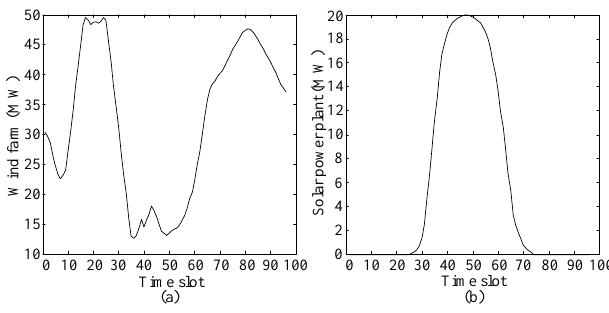
Figure 3. Predictive generating volume: ( a ) wind farm; ( b ) solar power plant.